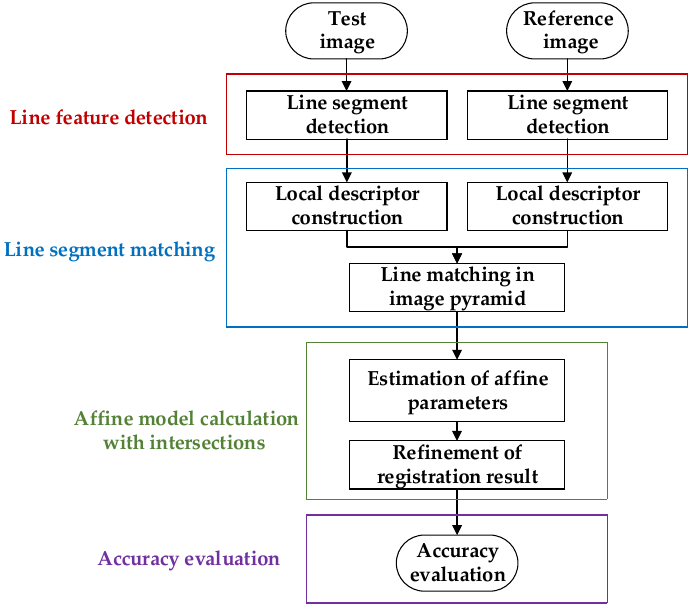
Figure 1. Flowchart of the proposed